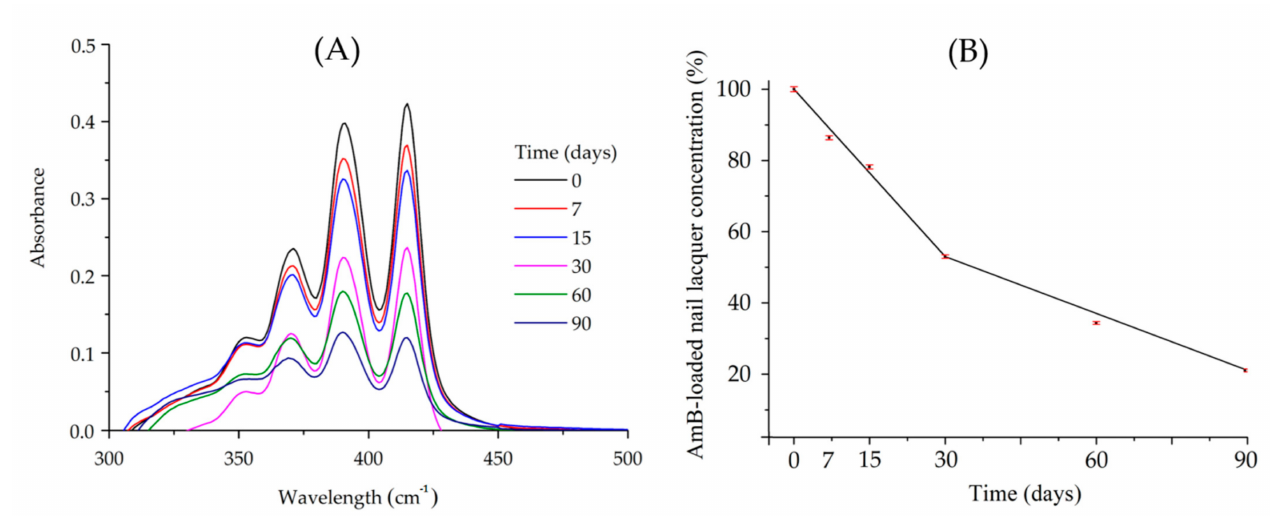
Figure 1. Spectroscopic signal emitted by the AmB’s chromophore group over 90 days. ( A ) Wavescan profile of AmB-loaded nail lacquer. ( B ) AmB-loaded nail lacquer’s concentration over